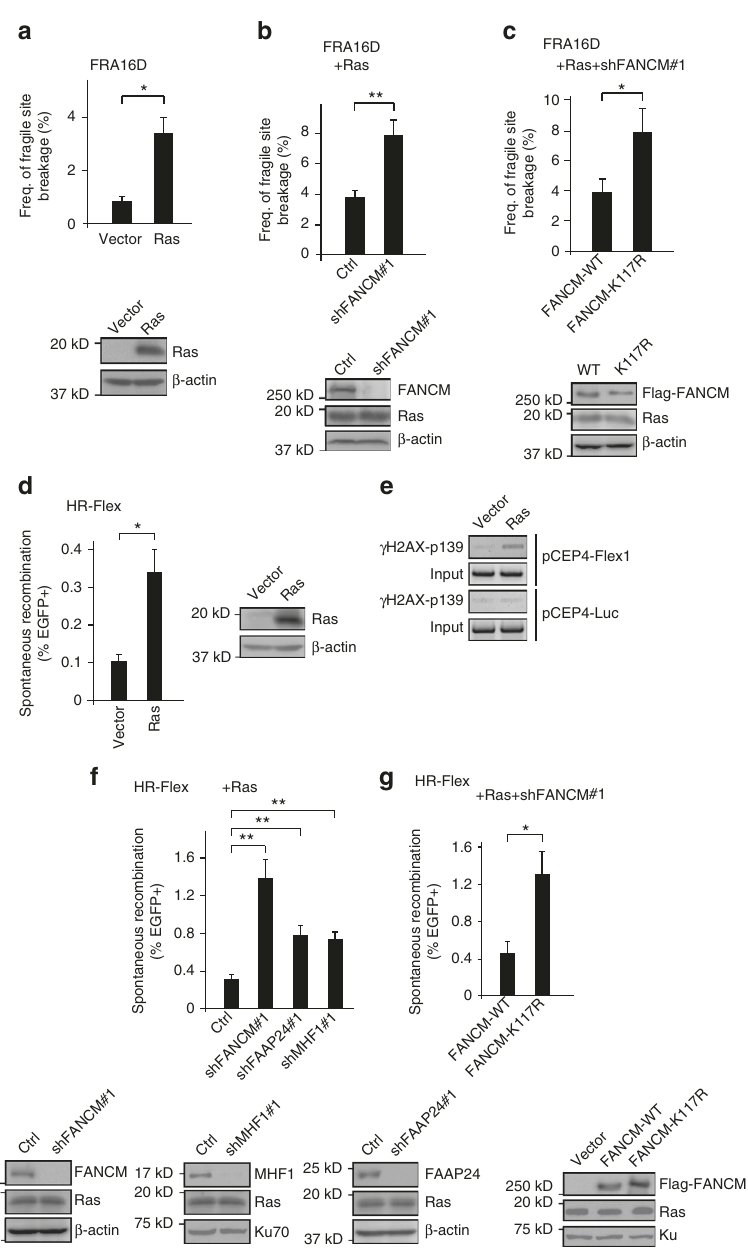
Fig. 4 FANCM is important for suppressing Ras-induced CFS expression and mitotic recombination at Flex1. a – c Frequency of CFS expression at FRA16D in HCT116 cells was determined after expressing H-Ras V12 (Ras) or vector ( a ), Ras along with FANCM shRNA or control vector ( b ), or Ras and Flag-FANCM (WT or K117R) with endogenous FANCM silenced by shRNA ( c ). Expression of Ras and FANCM is shown by western blot analysis. d , f , g Spontaneous recombination was determined in U2OS (HR-Flex) cells with p53 silenced by shRNA (to prevent Ras-induced senescence) 1 week after Ras expression ( d ), Ras expression following expression of indicated shRNAs or vector ( f ), or Ras and Flag-FANCM WT or K117R with endogenous FANCM silenced by shRNA ( g ). Indicated protein expression is shown by western blot analysis. e ChIP analysis of γ H2AX at Flex1 was performed in U2OS cells containing pCEP4-Flex1 or pCEP4-Luc plasmids 72 h after Ras